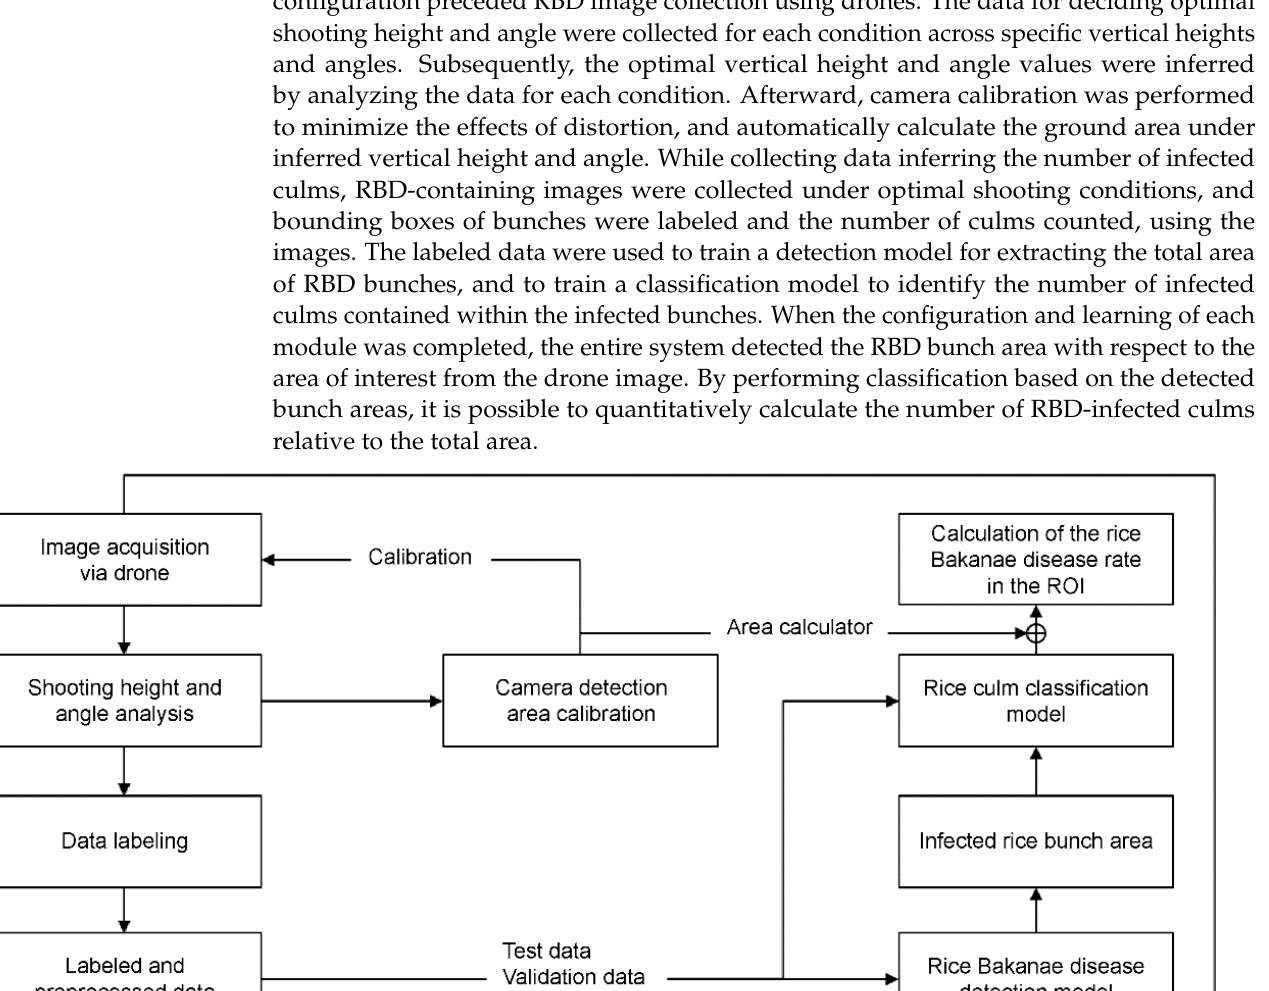
Figure 4. Example bunch and culm of rice plant.